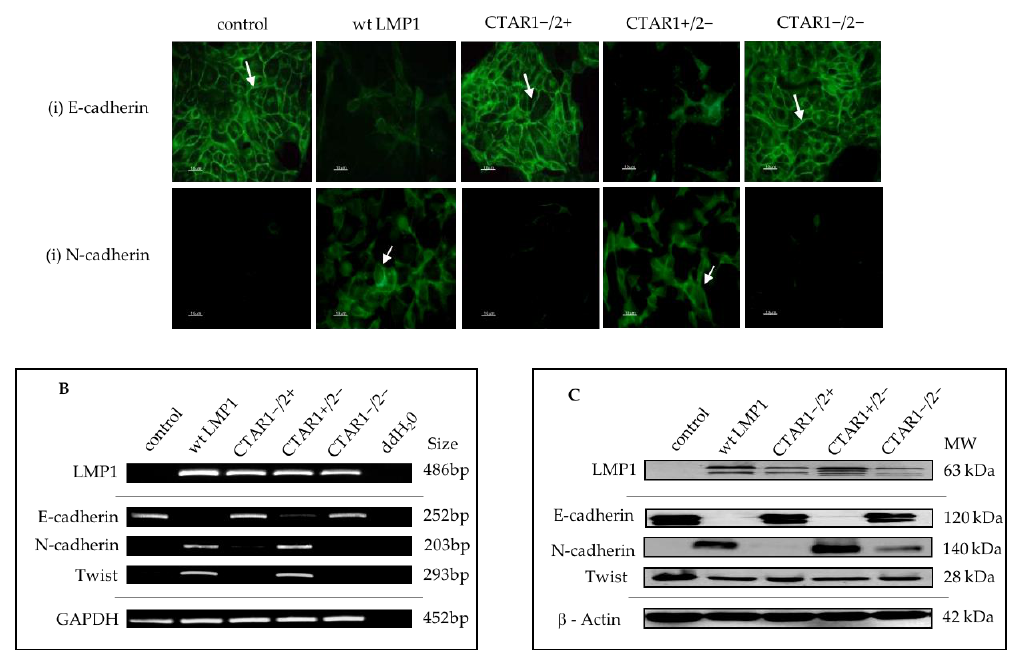
Figure 4. Characterisation of expression of EMT markers in LMP1-expressing MDCK cells. ( A ) Immunofluorescence staining confirmed downregulation of the epithelial marker, E-cadherin, as indicated by the white arrows, and a concomitant upregulation of the mesenchymal marker, N-cadherin, in wildtype LMP1 and CTAR1+/2− LMP1-expressing cells. Bar = 10 μm; ( B ) Reverse transcriptase polymerase chain reaction (RT-PCR) confirmed the loss of E-cadherin gene expression and the accompanied induction of N-cadherin gene expression in wildtype and CTAR1+/2− LMP1-expressing cells. The transcriptional repressor, Twist, was also upregulated in a CTAR1-dependent manner. The housekeeping gene for GAPDH was included as an internal loading control; ( C ) Western blotting further validated the changes in gene expression of both E-cadherin and N-cadherin at the protein level, but induction of Twist at the RNA level does not appear to be translated at the protein level. The structural protein, β-actin, was included as an internal loading control. N.B. All samples were collected as part of the same biological triplicate and therefore the same loading control and LMP1 expression control are used throughout.